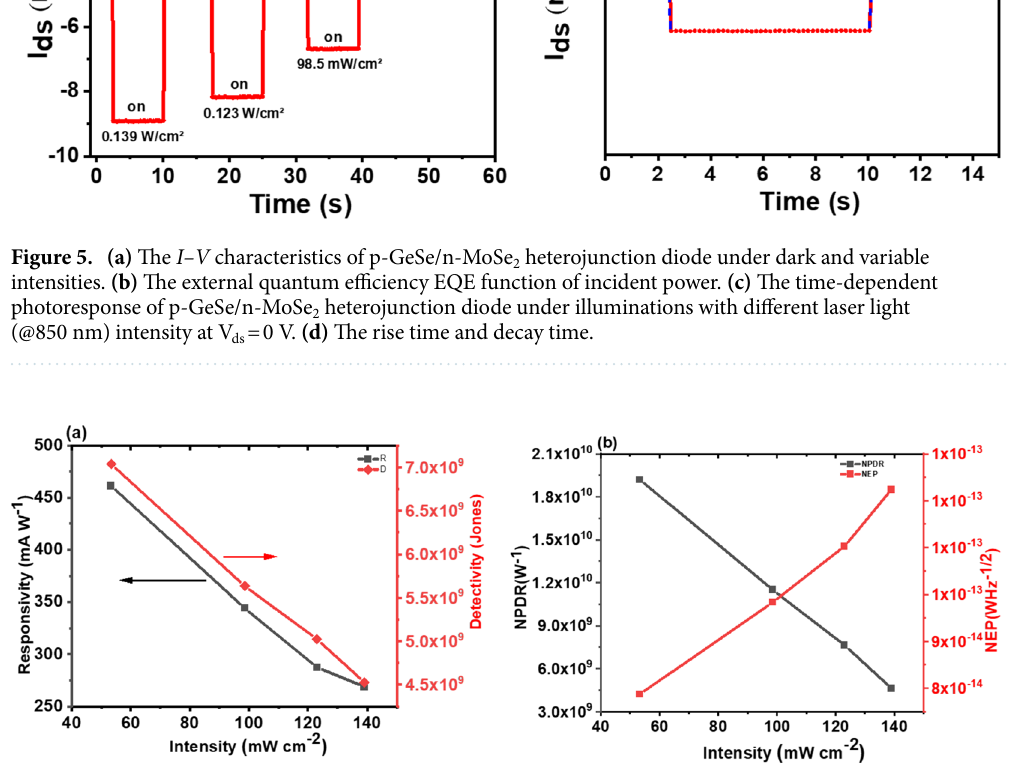
Figure 6. (a) The responsivity, R (mA W −1 ), and the detectivity, D (Jones) function of power intensities (b) the normalized photocurrent to dark current ratio NPDR (W −1 ) and the noise equivalent power NEP (W Hz −1/2 ) function of power